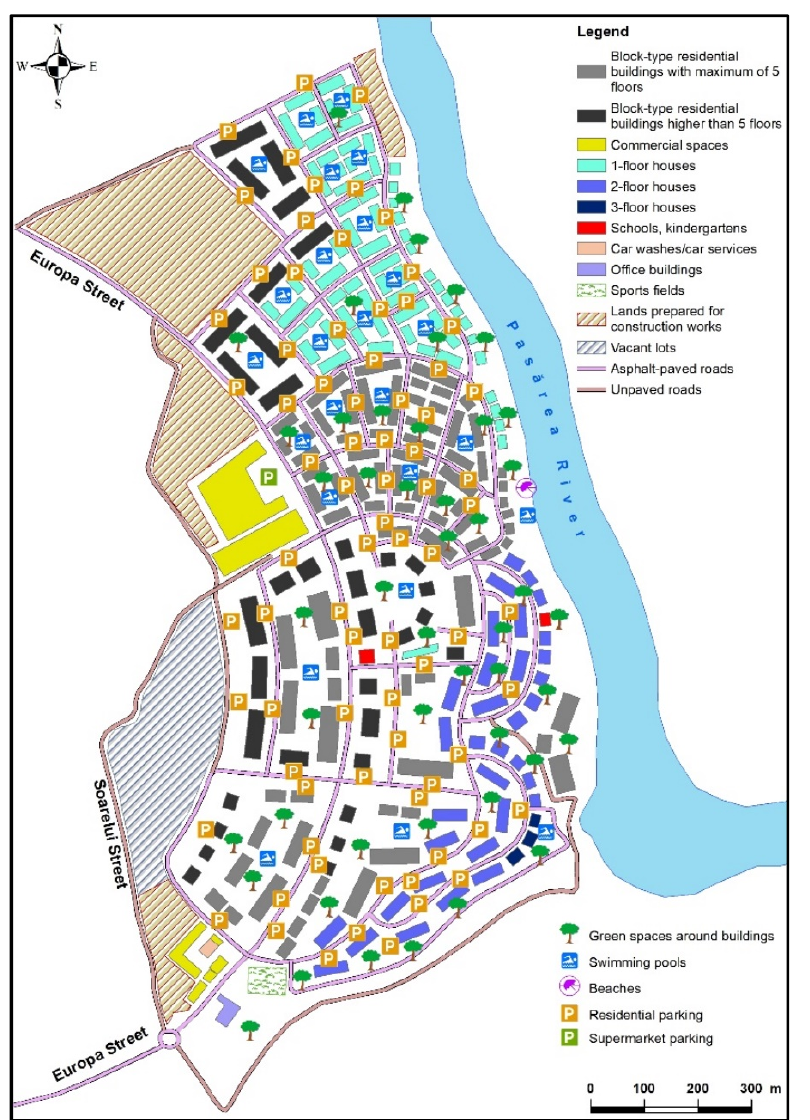
Figure 6. Residential features of the Cosmopolis area.